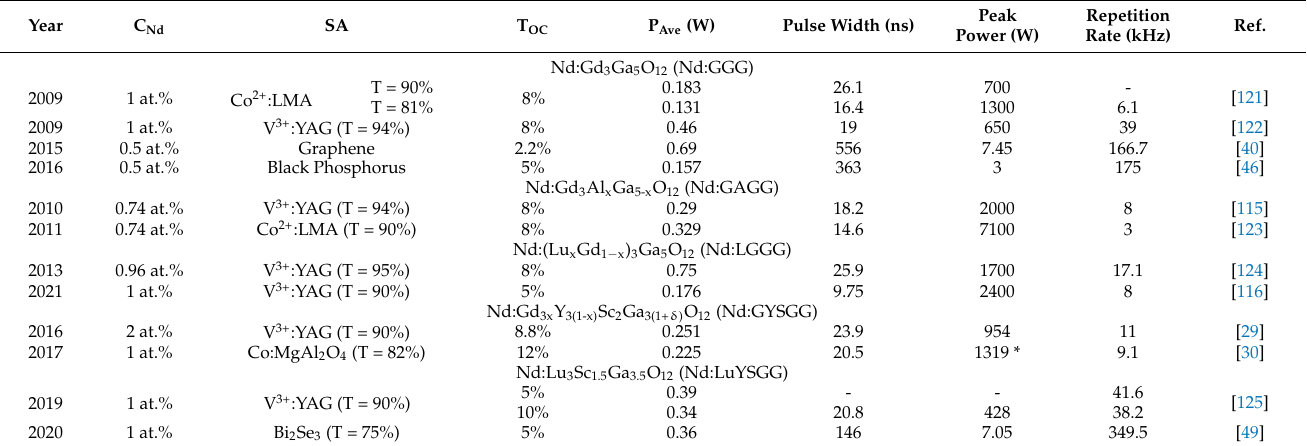
Table 4. Research progress on 1.3 µ m passively Q-switched neodymium-doped gallium garnet